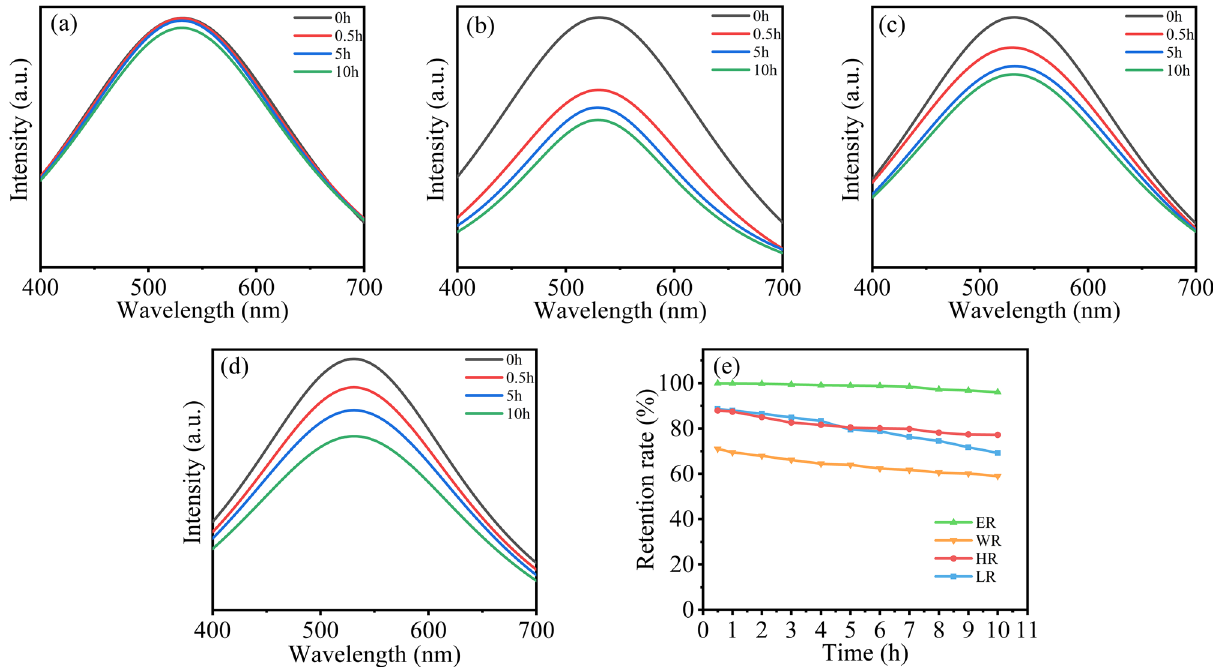
Figure 7. ( a ) The fluorescence spectra of the samples soaked in absolute ethanol for 0 h, 0.5 h, 5 h and 10 h. ( b ) The fluorescence spectra of the samples immersed in hot water at 80 °C for 0 h, 0.5 h, 5 h and 10 h. ( c ) The fluorescence spectra of the samples placed in a 100 °C oven for 0 h, 0. 5 h, 5 h and 10 h. ( d ) The fluorescence spectra of the samples irradiated with UV light for 0 h, 0.5 h, 5 h and 10 h. ( e ) The trends of the fluorescence retention rate of the ZnO QDs water-based fluorescent ink